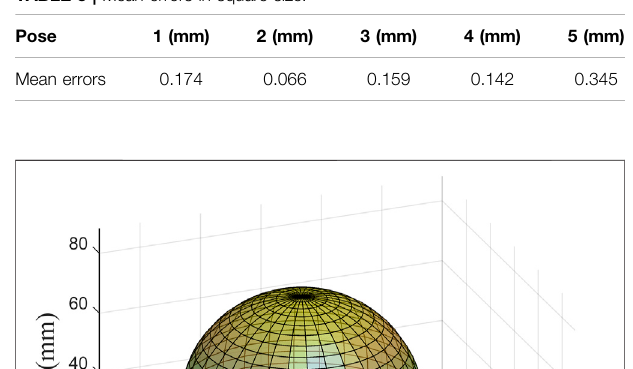
TABLE 3 | Mean errors in square size.